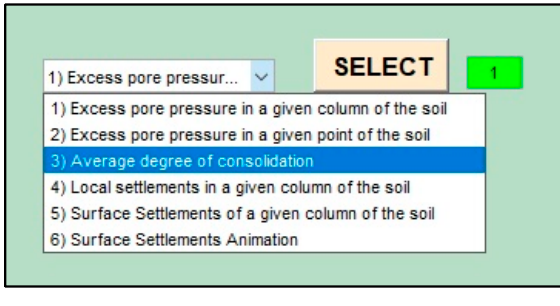
Figure 9. Representation selection screen.